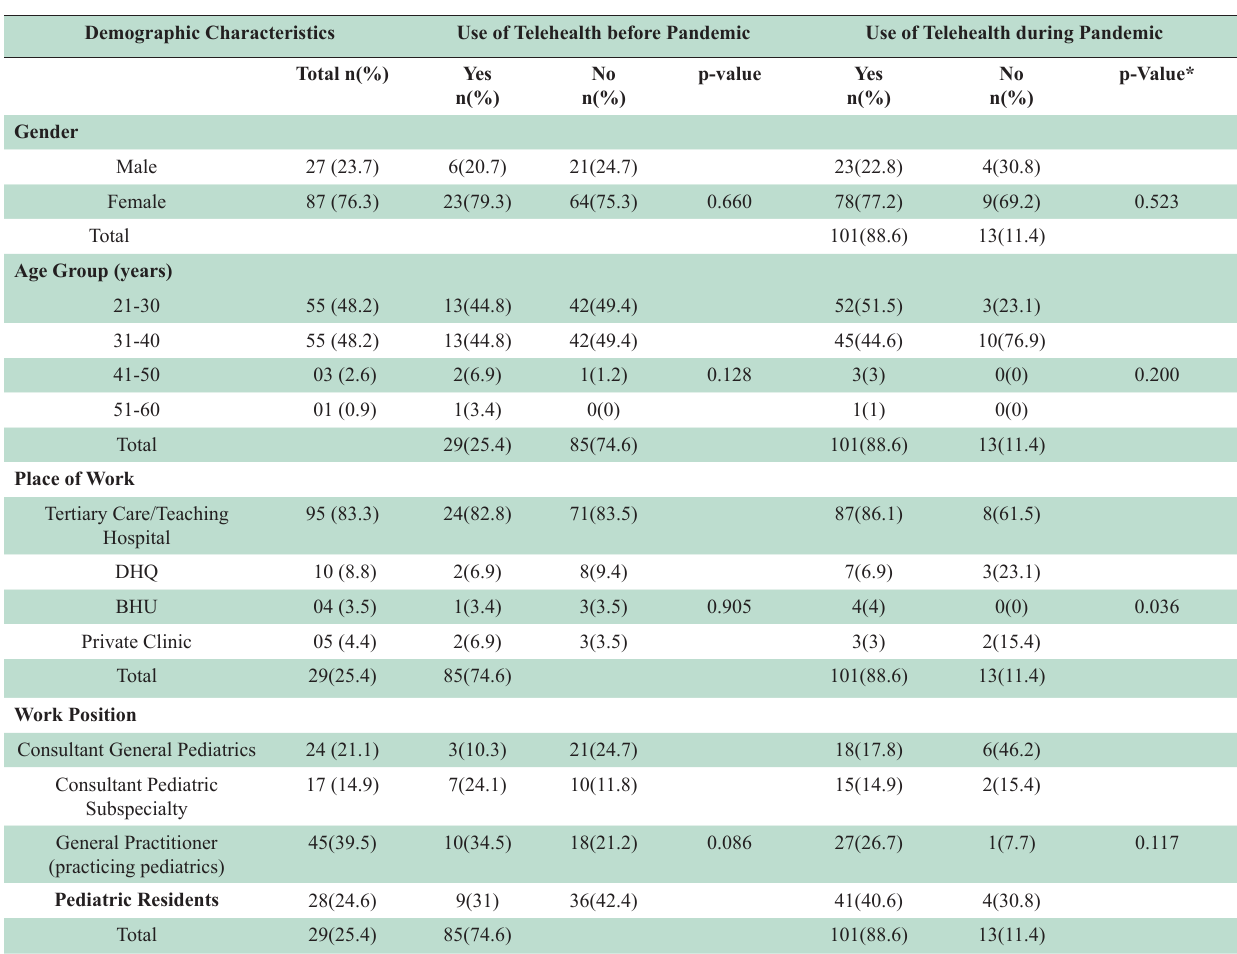
*by applying Fischer’s Exact test; n=total no. of pediatricians Table-II: Demographic details of the study population and Comparison of Telehealth use Before and During the Pandemic